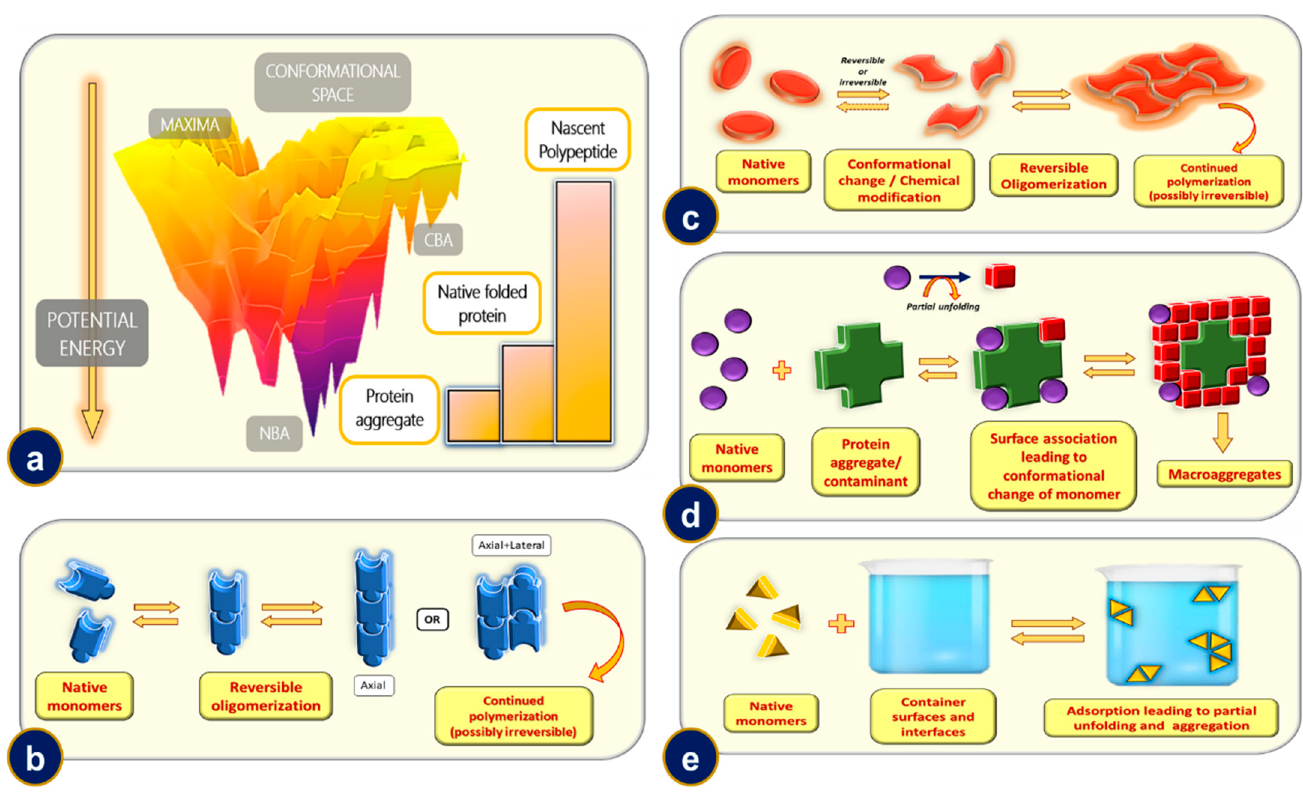
Figure 7. Aggregation mechanisms: ( a ) the potential energy surface for a protein folding process. The competing basins of attractions are populated by the folding intermediates which have higher energy than the native folded protein. The native basin of attraction is a low-lying critical point, populated by the functionally folded native protein. The aggregated being thermodynamically stabler lie even more downhill, populating the lowest points of the PES; ( b ) various mechanisms for modeling protein aggregation: reversible oligomerization of the native monomers leading to irre- versible macroaggregates; ( c ) conformational change of native monomer followed by b1 mechanism; ( d ) microaggregate/contaminant induced surface aggregation leading to irreversible polymerization and aggregation; ( e ) aggregation induced at phase interface or on rough